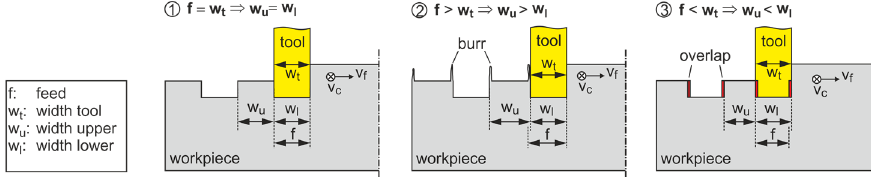
Figure 5. Structure width depending on the feed.